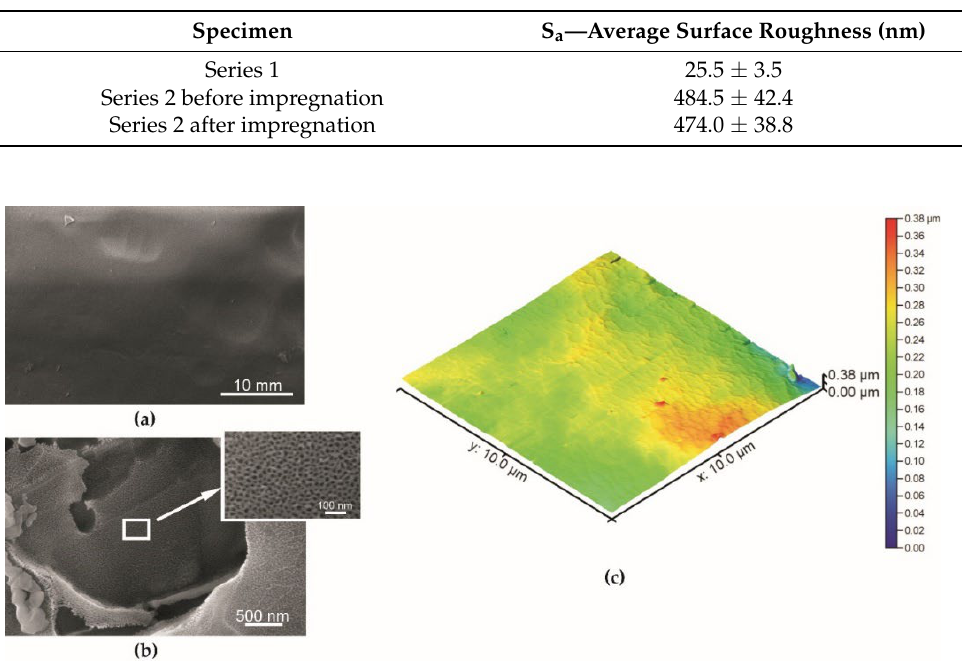
Figure 4. The surface of the specimen from Series 1 (basic anodization process): ( a ) mag. 10,000×: ( b ) mag. 100,000×, ( c ) AFM topography.